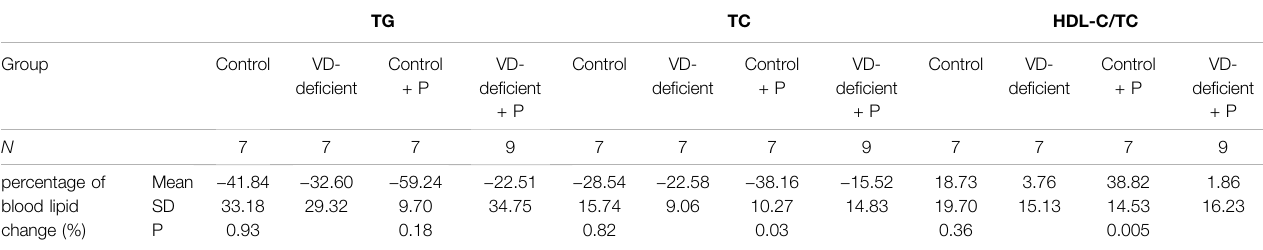
TABLE 1 | The effect of vitamin D de fi ciency on the lipid-lowering ef fi cacy of pravastatin (percentage of blood lipid change) in rats.